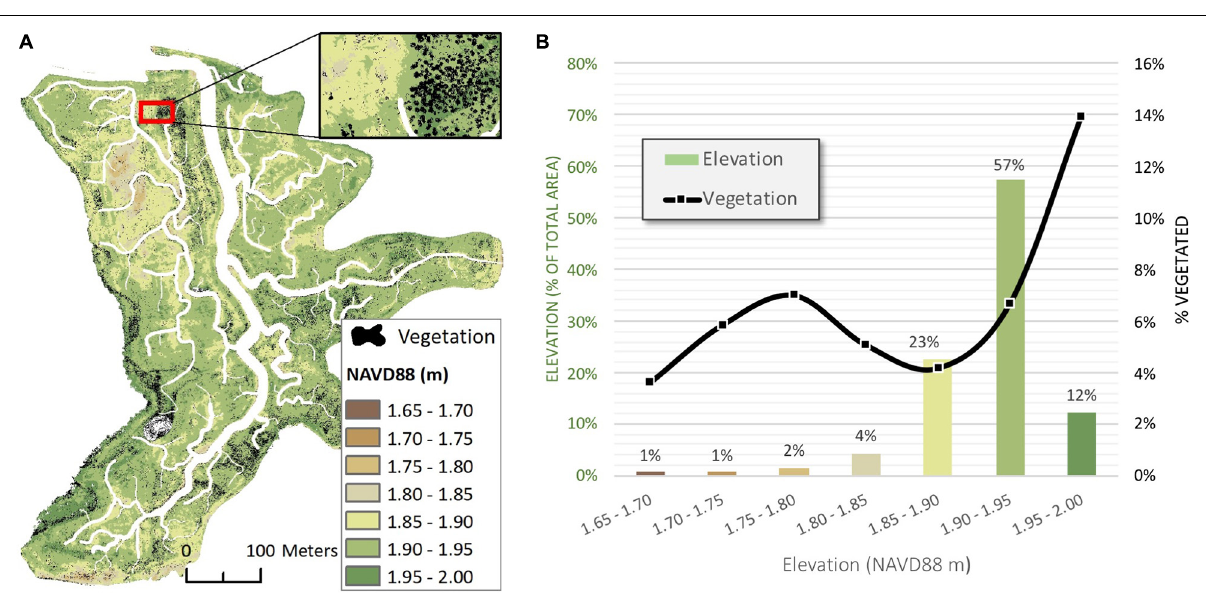
FIGURE 6 | (A) Map of classified vegetation on top of an August 2018 DEM showing elevation in 5 cm increments. (B) Percent of total area (histogram) and percent vegetated area (line) in each elevation bin. Percent vegetated area is the area of classified vegetation in an elevation bin out of the total area in that